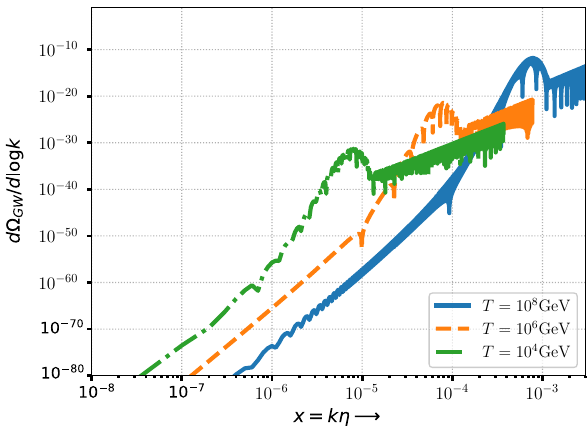
Fig. 1 Gravitational wave spectrum as a function of x = k η . We have fixed n = 10 − 6 and varied temperature